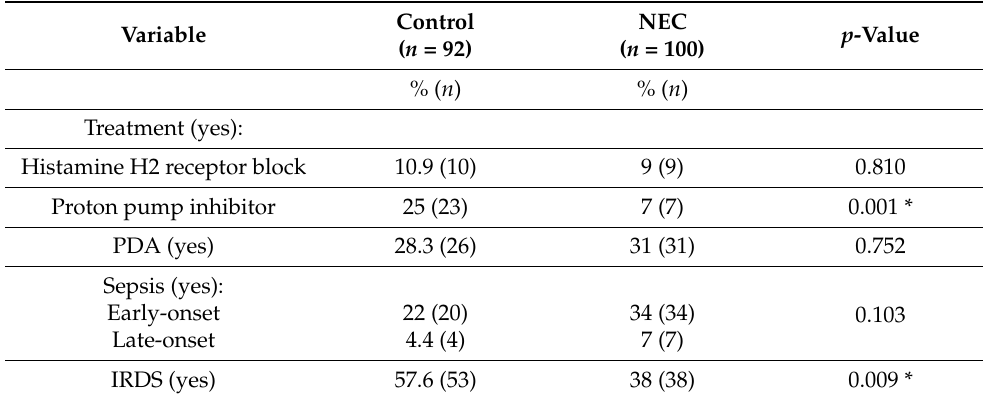
Table A2. Risk factors for NEC in Control and NEC